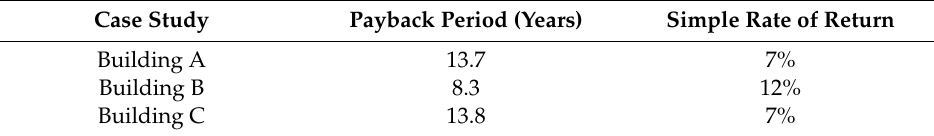
Table 5. Simple payback period and simple rate of return of the